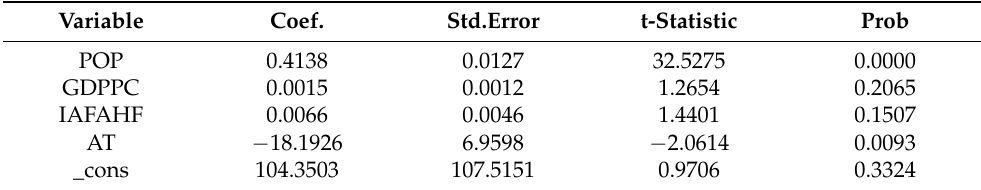
Table 8. Multiple linear regression of VAPI.